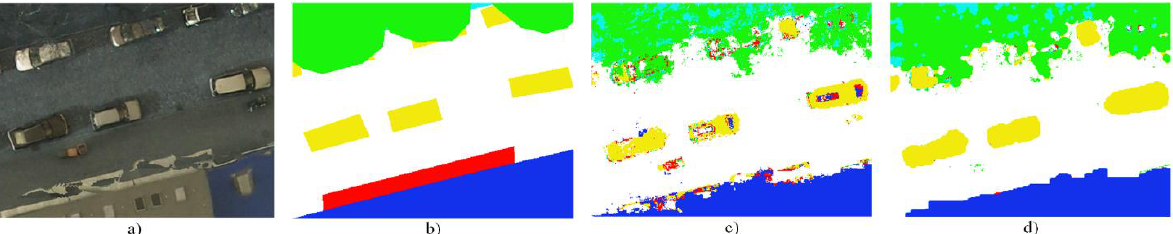
Figure 10. Car refinement on a part of patch No. 5-11 a) RGB view b) Ground truth c) Classified image d) Result of refinement by spatial operators.